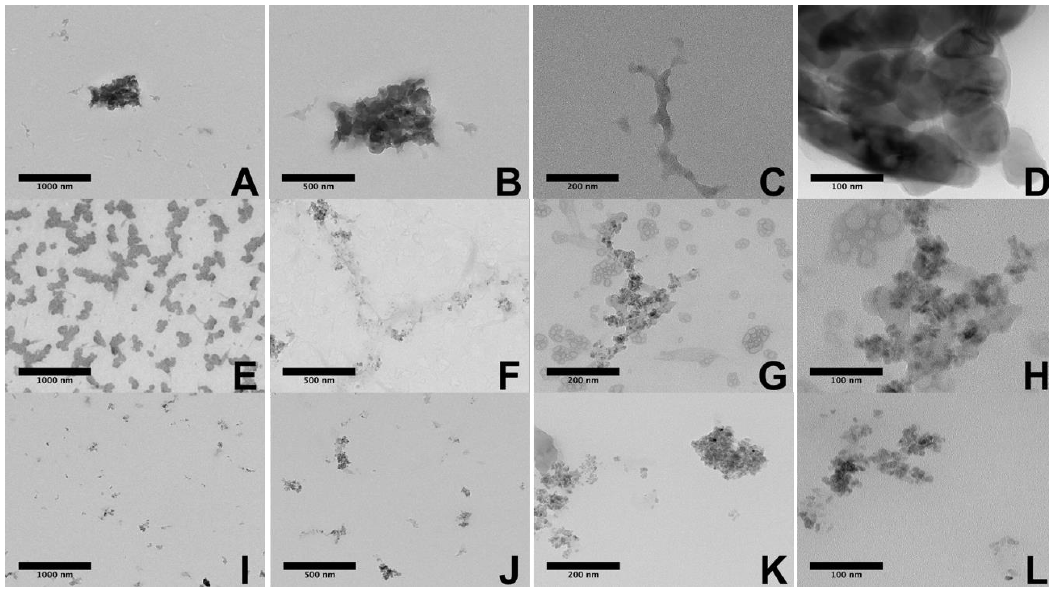
Figure 7. HR-TEM images of the different beads: CS-GO-GLA ( A ) 1000 nm, ( B ) 500 nm, ( C ) 200 nm, ( D ) 100 nm; CS-GO-TiO 2 -GLA ( E ) 1000 nm, ( F ) 500 nm, ( G ) 200 nm, ( H ) 100 nm; CS-TiO 2 -GLA ( I ) 1000 nm ( J ) 500 nm ( K ) 200 nm, ( L ) 100 nm.